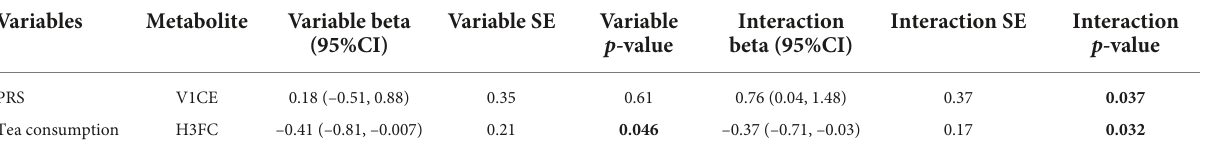
TABLE 3 Interaction effects in predicting osteoporosis